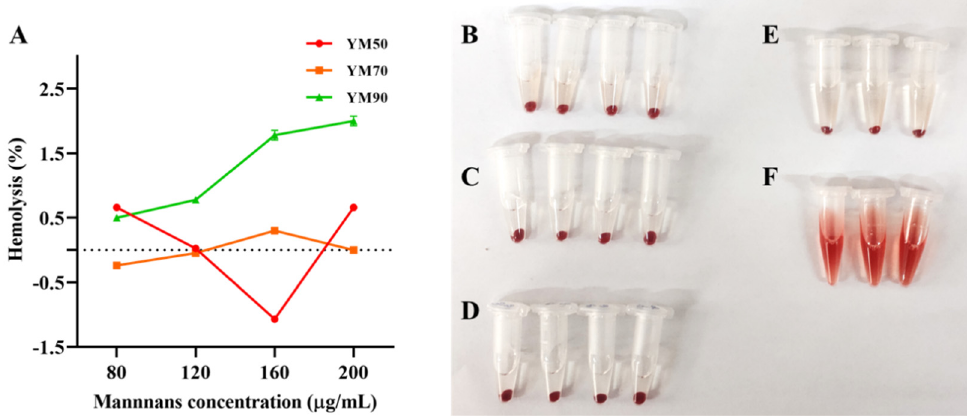
Figure 6. Hemolytic mannan assay. ( A ) Relative rate of hemolysis in mice erythrocytes upon incubation with mannans’ solution at incremental concentrations. The presence of hemoglobin in the supernatant was observed in ( B ) YM50 mannans, ( C ) YM70 mannans, ( D ) YM90 mannans, ( E ) negative control (PBS), and ( F ) positive control (water), respectively. Data are mean ± SD ( n = 3).